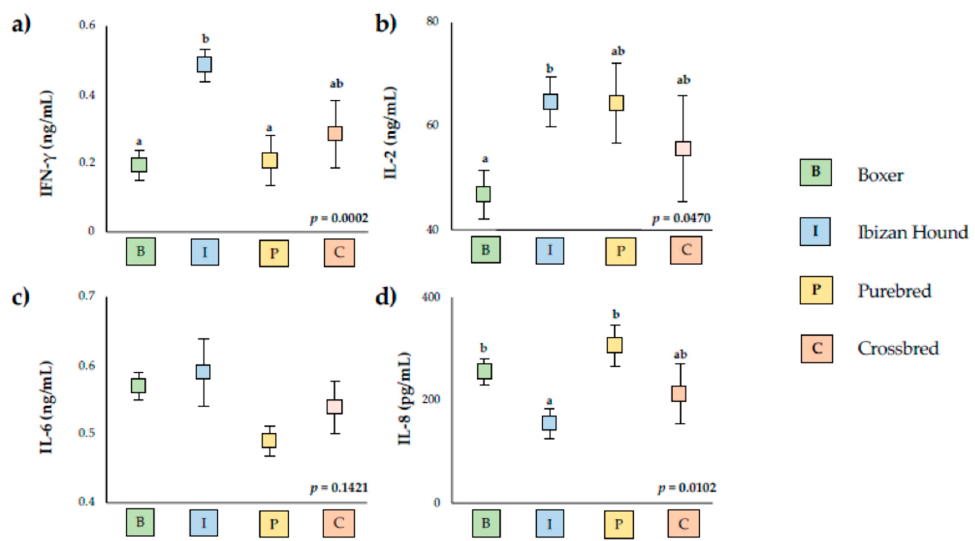
Figure 2. Serum levels of the cytokines studies in boxer (B) and Ibizan hound (I) and another purebred (p) and crossbred (C). ( a ) Interferon gamma (IFN- γ ), ( b ) Interleukin 2 (IL-2), ( c ) Interleukin 6 (IL-6), and ( d ) Interleukin 8 (IL-8). Squares represent mean values for each group analyzed, and vertical lines represent standard deviation. The values for IL-8 are pg/mL, and for IFN- γ , IL-2, and IL-6, they are ng/mL. Each cytokine value possessing different letters differs significantly ( p < 0.05). None of the Ibizan hounds were infected. The serum levels of IFN- γ were similar in boxer, elder animals, and infected animals, and they were lower than Ibizan hounds ( p < 0.0001). No differences between infected animals and other groups were found in the se- rum levels of analyzed cytokines.